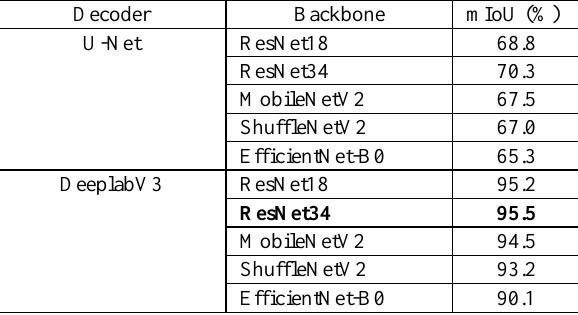
Table 4. Our simulated validation set results